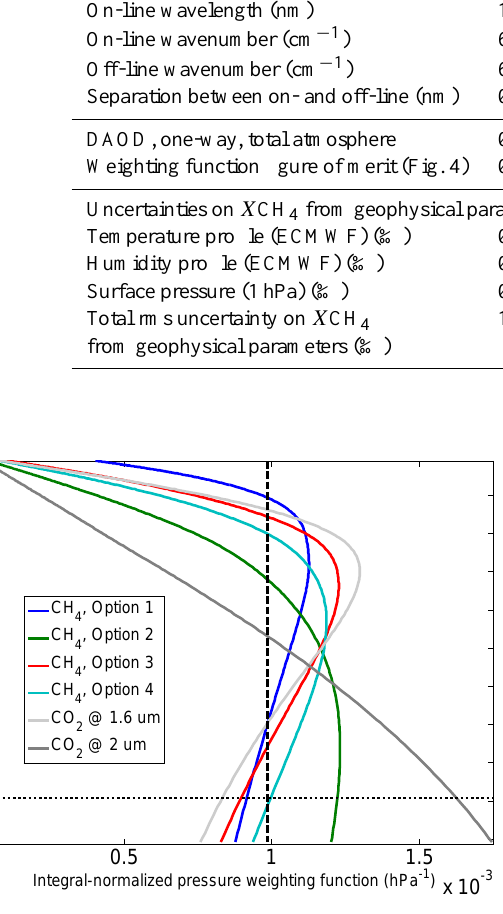
Fig. 4. Integral-normalized pressure weighting functions of IPDA lidar for all four suitable methane absorption trough positions at 1.6µm listed in Table 1, and for carbon dioxide line wing posi- tions at 1.6 and 2µm for comparison. Also shown is a hypothetical uniform weighting function (normalized; vertical dashed line) and the assumed top of the lowest 1-km layer (dotted horizontal line at 894hPa) used to define the figure of merit of the weighting function. Option 2 at 1645nm is selected due to its outstanding sensitivity in the lower